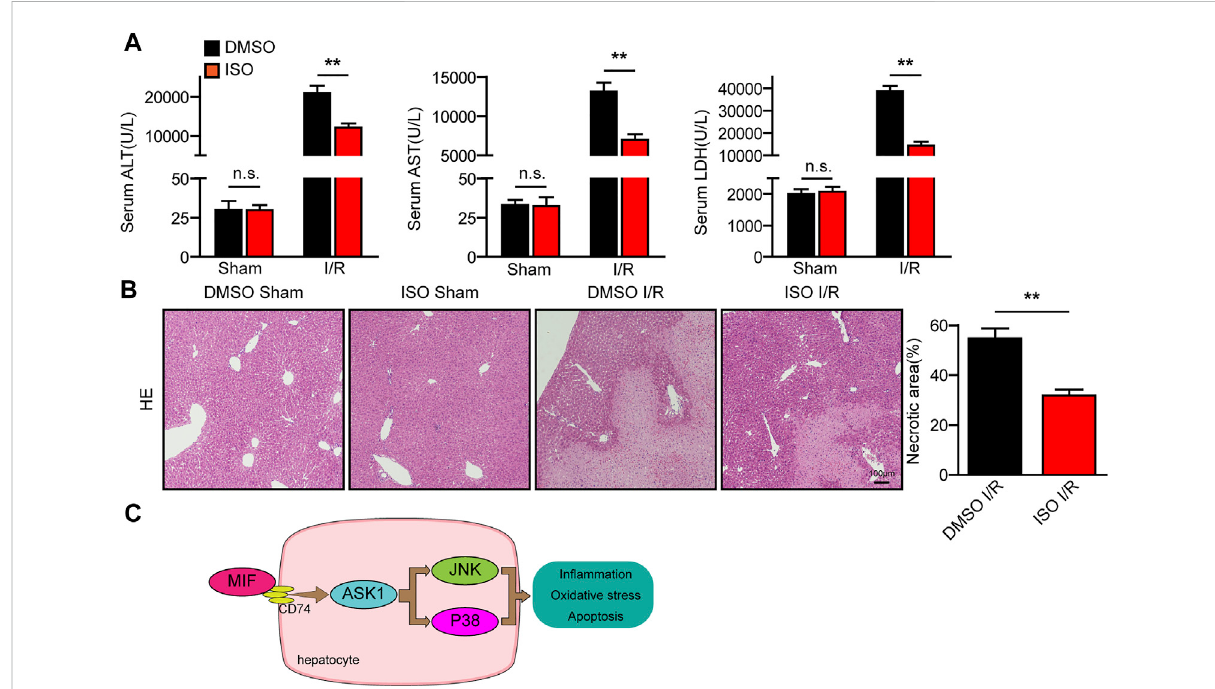
FIGURE 9 Pharmacological inhibition of MIF attenuated the I/R responsive liver injury. (A) Serum ALT/AST/LDH activities in mice after hepatic I/R surgery ( n = 6/group). (B) Representative histological HE-stained images and statistics showing necrotic areas in liver tissue of mice after hepatic I/R surgery ( n = 6/group). Scale bar, 100 μ m. (C) Mechanism of MIF regulating liver I/R injury. All data are presented as the mean ± SD. Levels of statistical signi fi cance are indicated as** p < 0.01. For statistical analysis, one-way ANOVA with Bonferroni ’ s post hoc analysis or Tamhane ’ s T2 post hoc